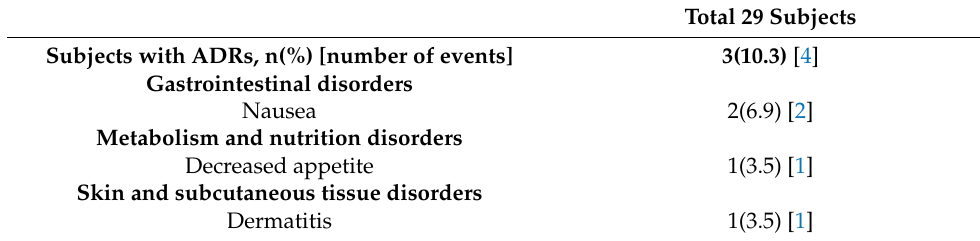
Table 4. Adverse drug reactions (ADRs) according to SOC and